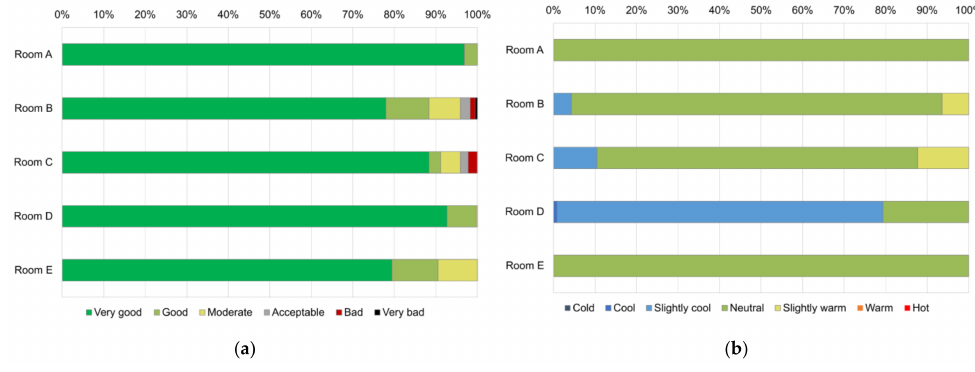
Figure 6. Percentage share of individual categories in the assessment of air quality: ( a ) by carbon dioxide concentration (Table 5); ( b ) assessments according to the PMV indicator (as shown in Figure 1).